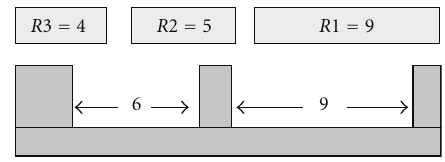
Figure 2: The initial state of holes and requests.